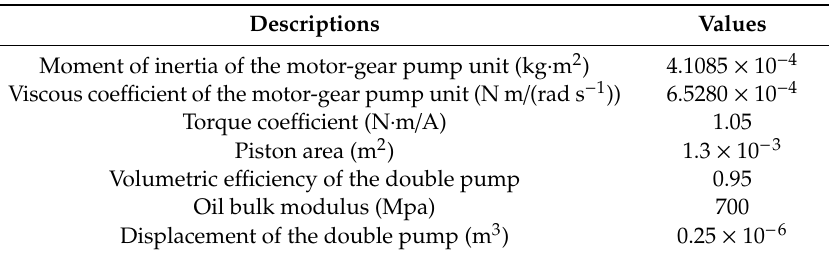
Table 1. Parameters of the hydraulic system of the simulation model.